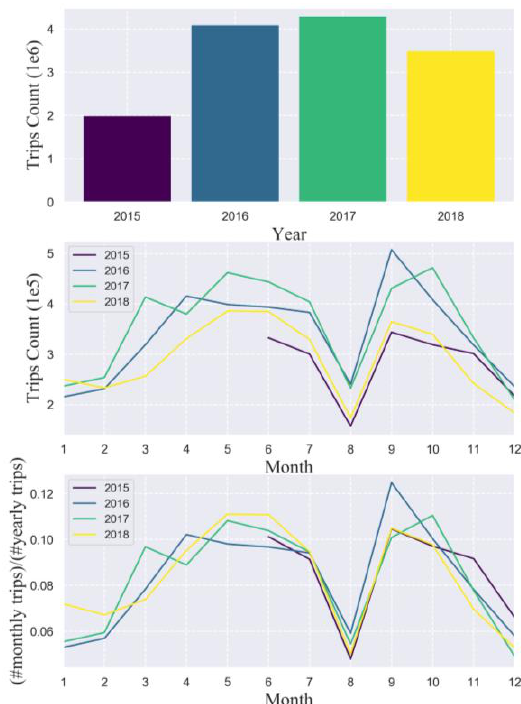
Figure 3. Evolution of BikeMi use in time. (a) Frequency of use yearly; (b) Frequency of use on a monthly basis per year; (c) Relative frequency of use on a monthly basis per year 2.2.1